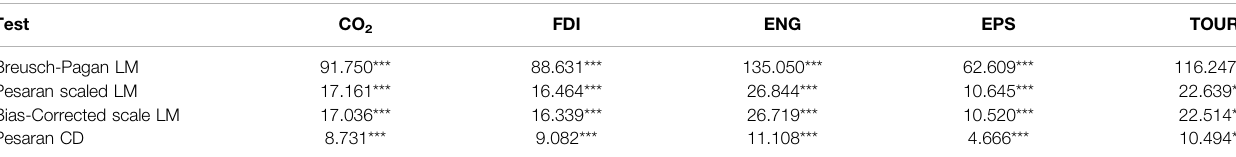
TABLE 3 | Results of CD